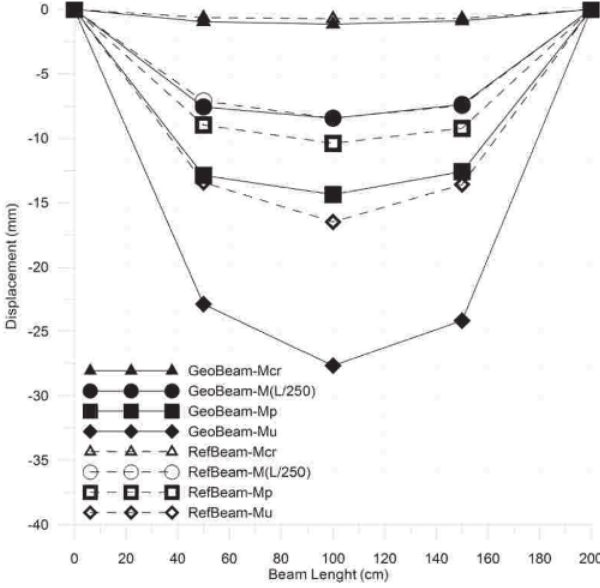
Figure 5 Vertical displacement along the beams length, measured by the LVDTs during the loading test